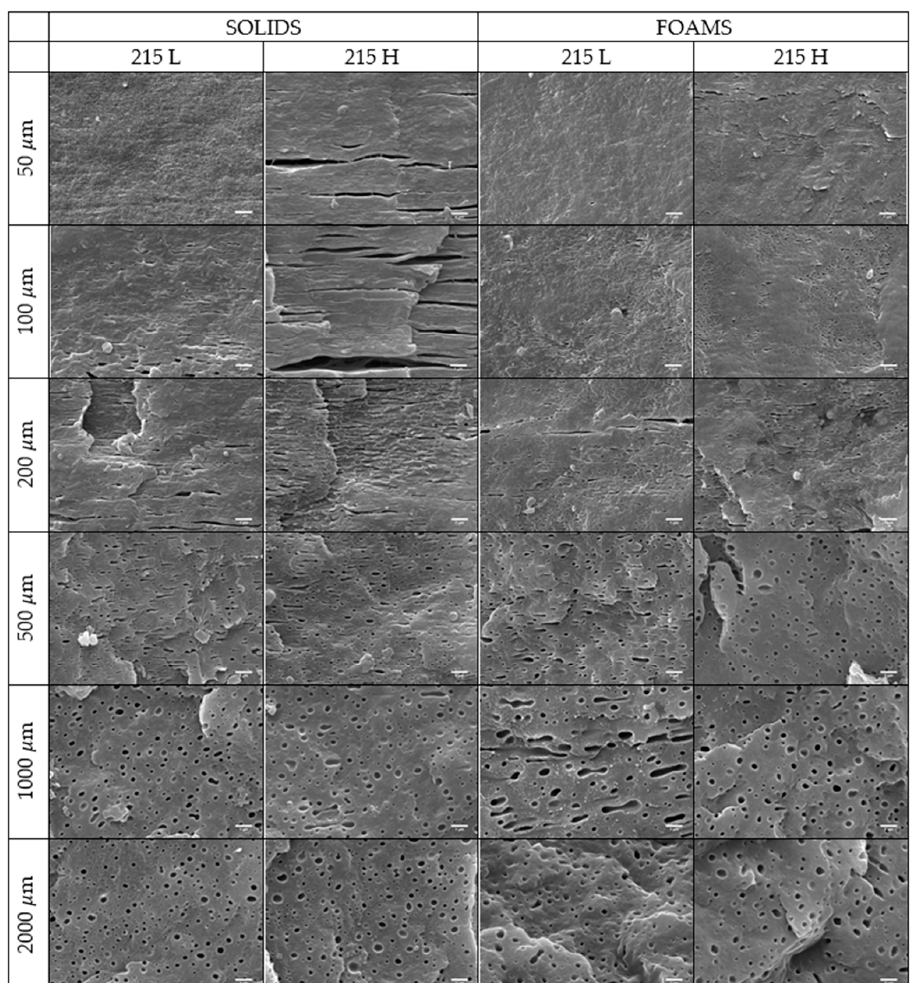
Figure 3. SEM images of xylene etched samples for different distances from the skin of the injection molded sample. In the core of the foam, images were taken in the interior of the walls. The scale bar represents 1 μ m.